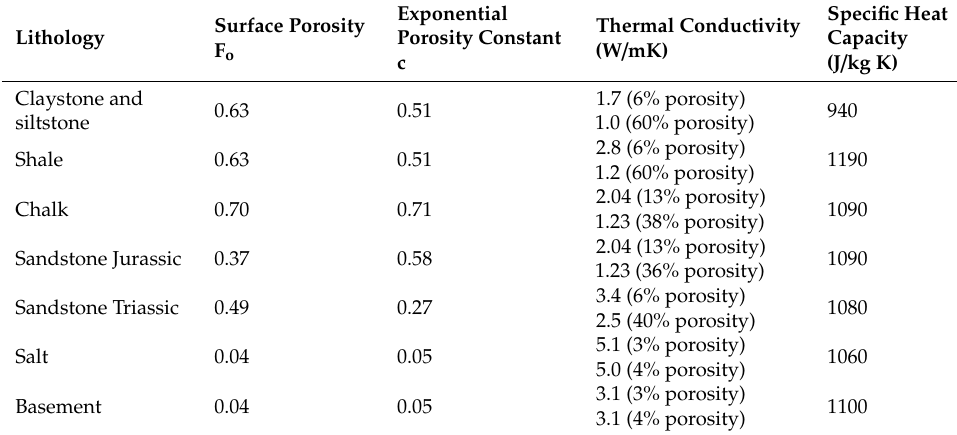
Table 1. Lithology parameters used in the basin modeling.